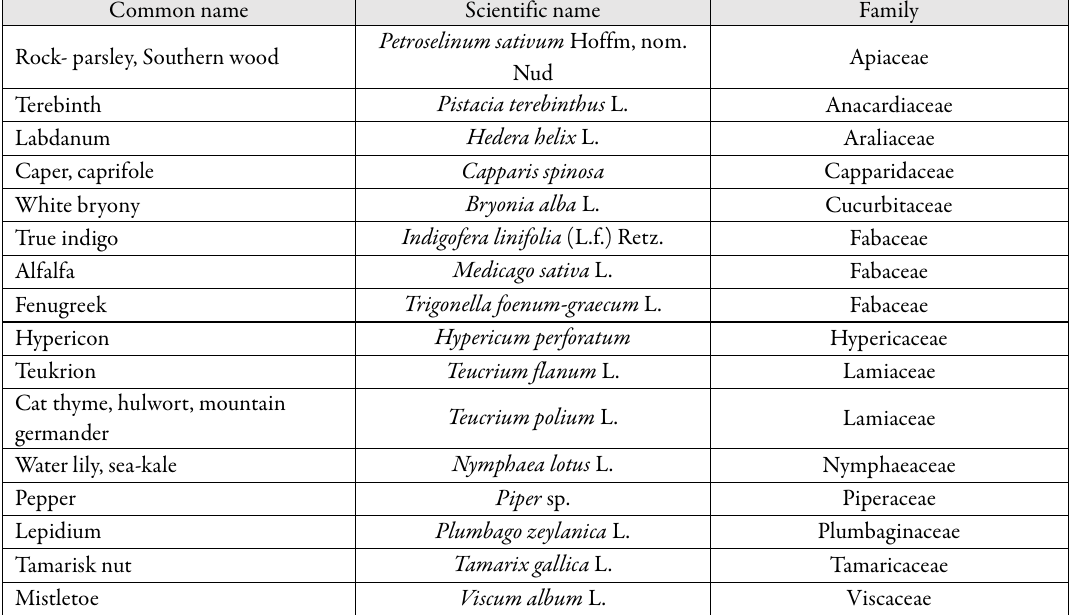
Table 11. The medicinal herbs which were found effective against spleen disease on the basis of second volume of Canon (Ghobadi Pour et al ., 2019)